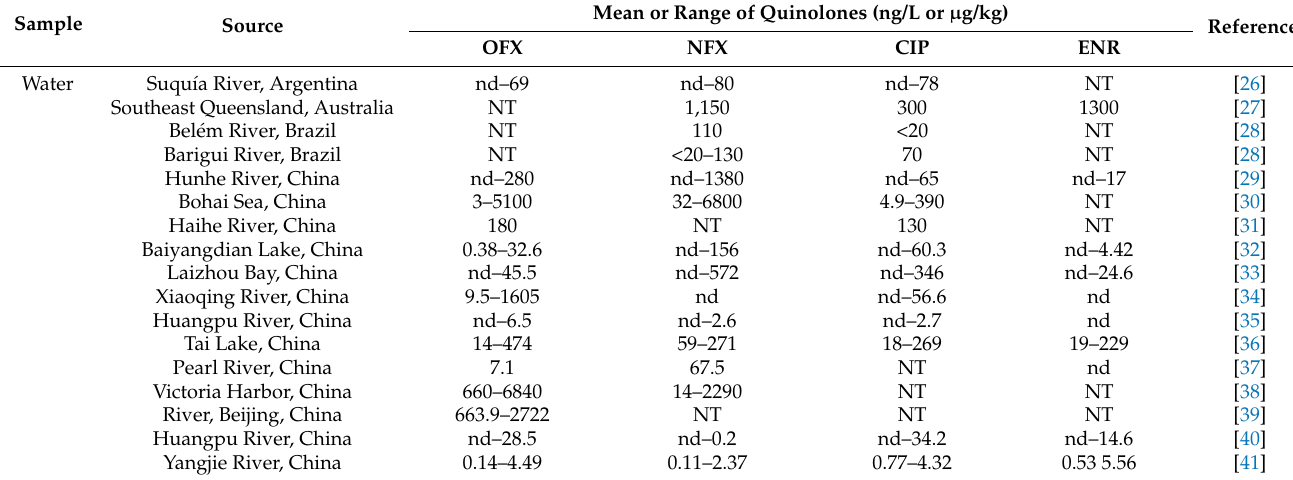
Table 1. Detection of residues of various quinolones in aquatic